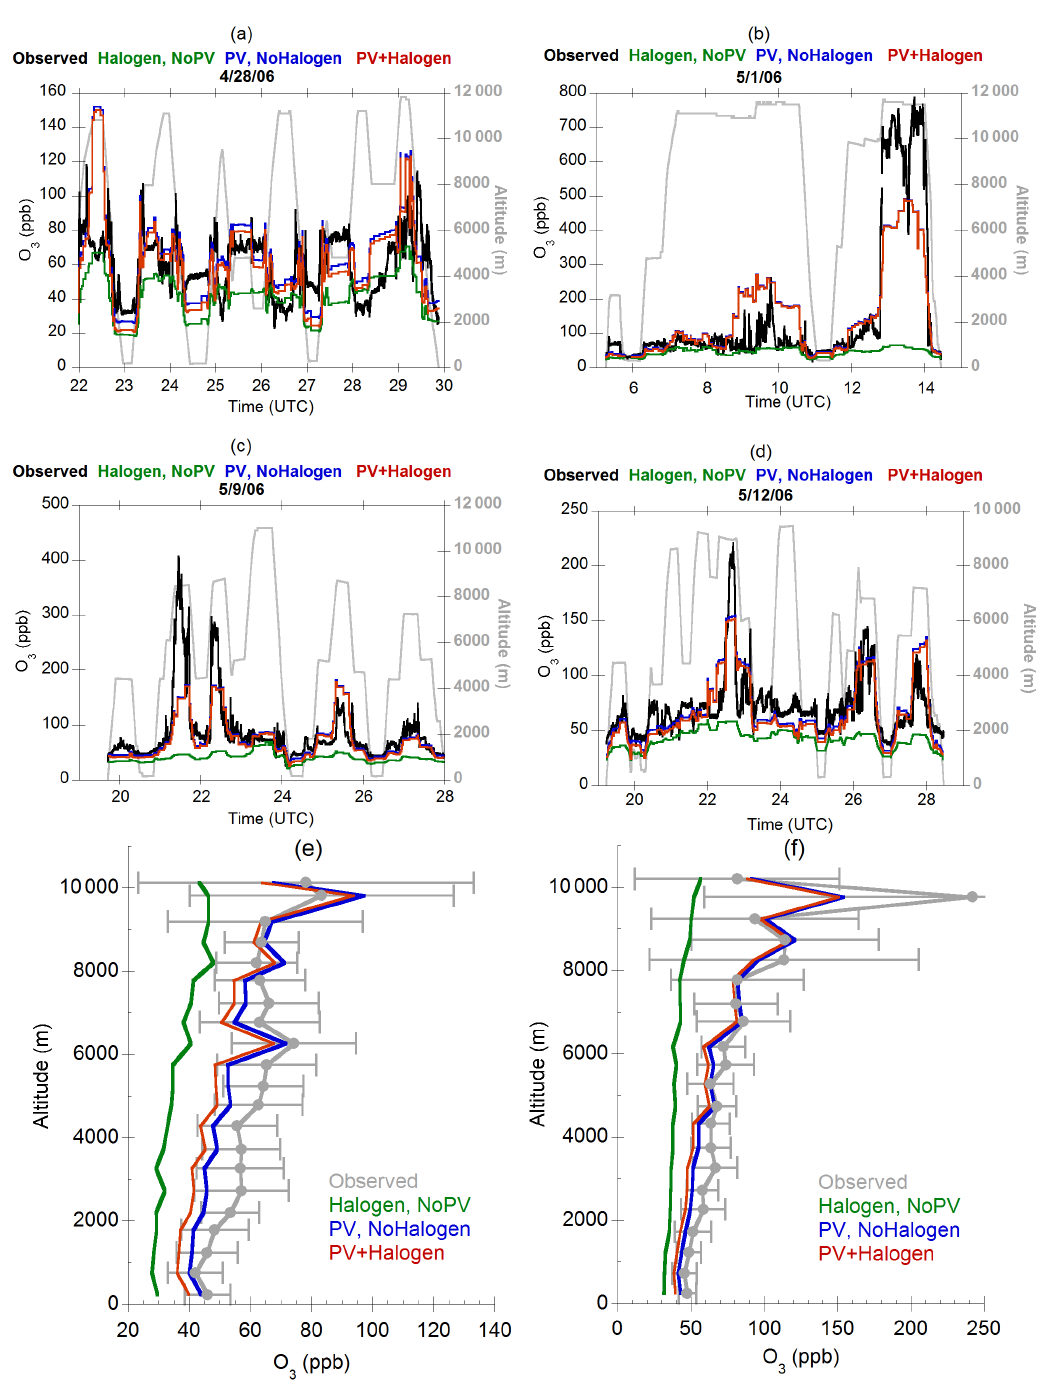
Figure 5. Comparison of simulated 3-D distributions of O 3 mixing ratios with observations from the DC-8 aircraft during the INTEX-B field campaign: (a–d) comparison of observed O 3 and simulated values from various model configurations along flight tracks on specific days; (e) comparison of model and observed campaign average O 3 vertical profile for flights over the subtropical Pacific during 17 April– 1 May 2006; (f) comparison of model and observed campaign average O 3 vertical profile for flights over the subarctic Pacific during 1–15 May 2006. Also shown in panels (e) and (f) is ± 1SD for the observed values. Also shown in panels (a–d) is the aircraft altitude along the flight